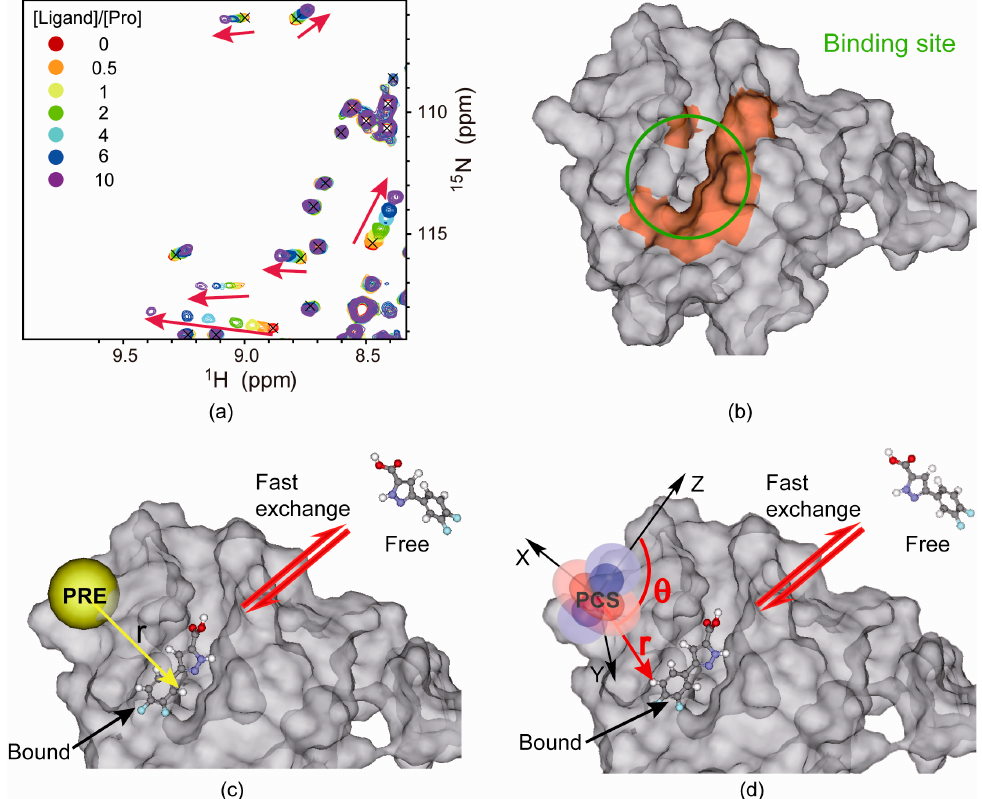
Figure 2. A structural model of a weakly bound protein–ligand complex derived from limited